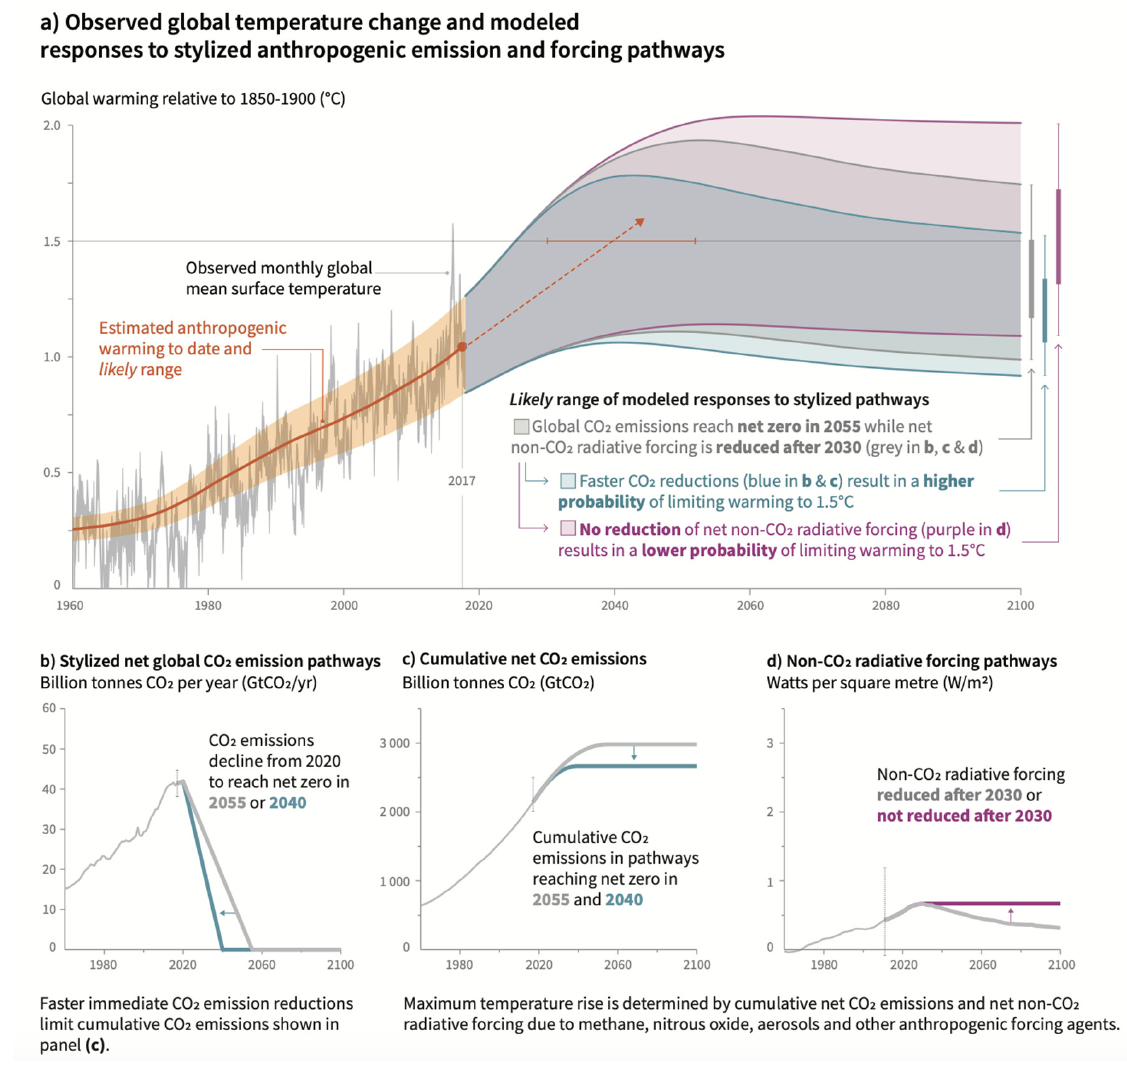
Figure 1. Cumulative emissions of CO 2 and future non-CO 2 radiative forcing determine the probability of limiting warming to 1.5 ◦ C (reproduced from Figure SPM.1 in